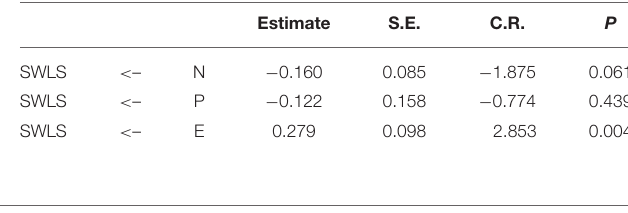
TABLE 2 | Fitting